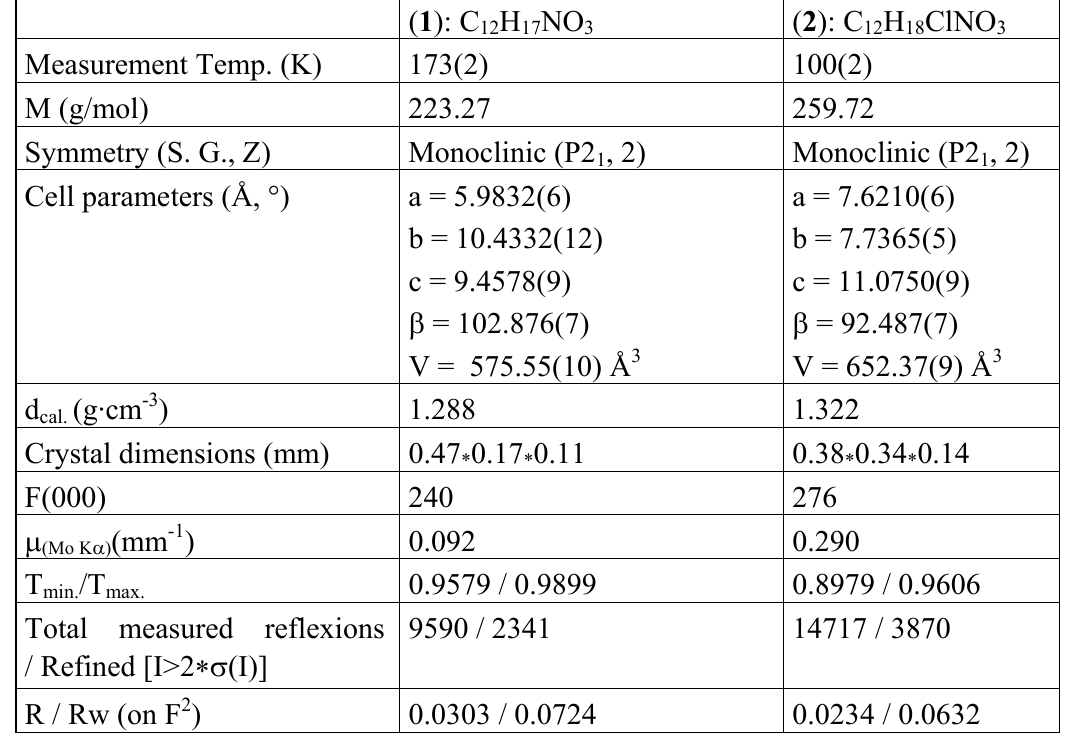
Table 3. Crystal and experimental data of 1 and